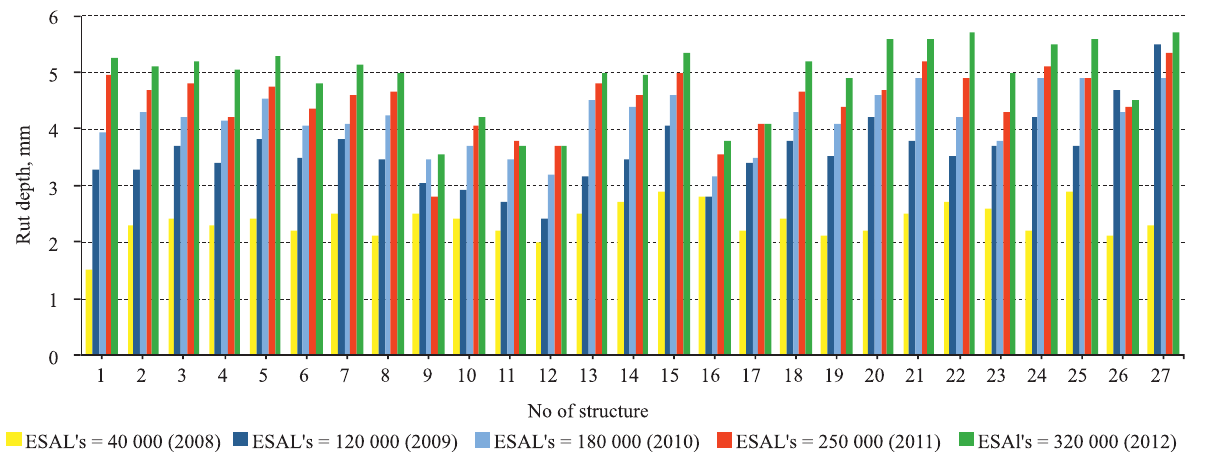
Fig. 8. Distribution of rut depth in the different pavement structures dependent on ESAL’s